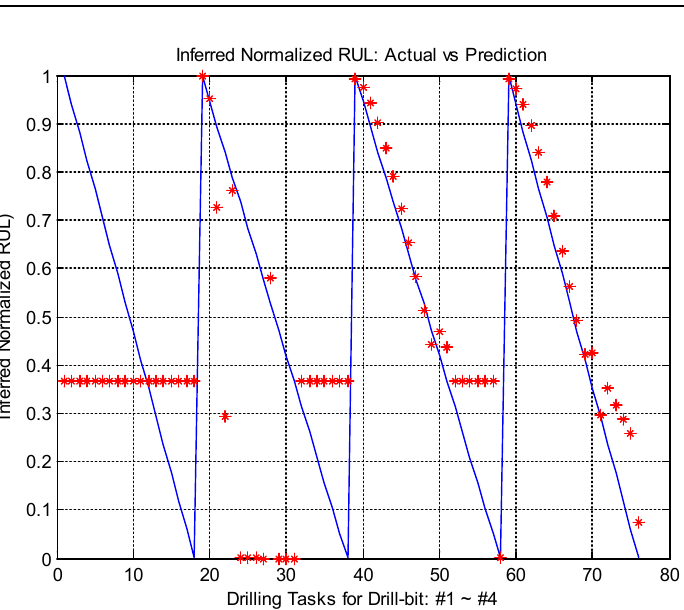
Figure 9. Normalized inferred RUL (blue line) vs. predicted RUL (red dotted line) for drill-bits #5~#8 in a delayed online setup.